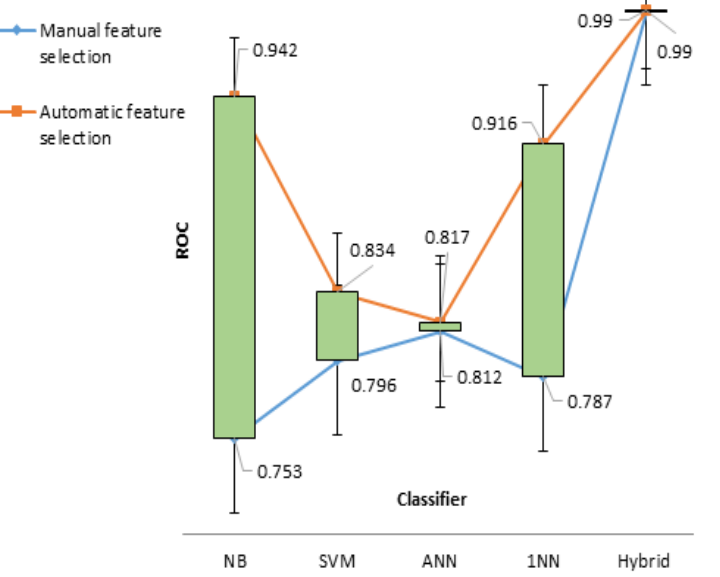
Figure 7. ROC comparison of hybrid modeling with other experiments.